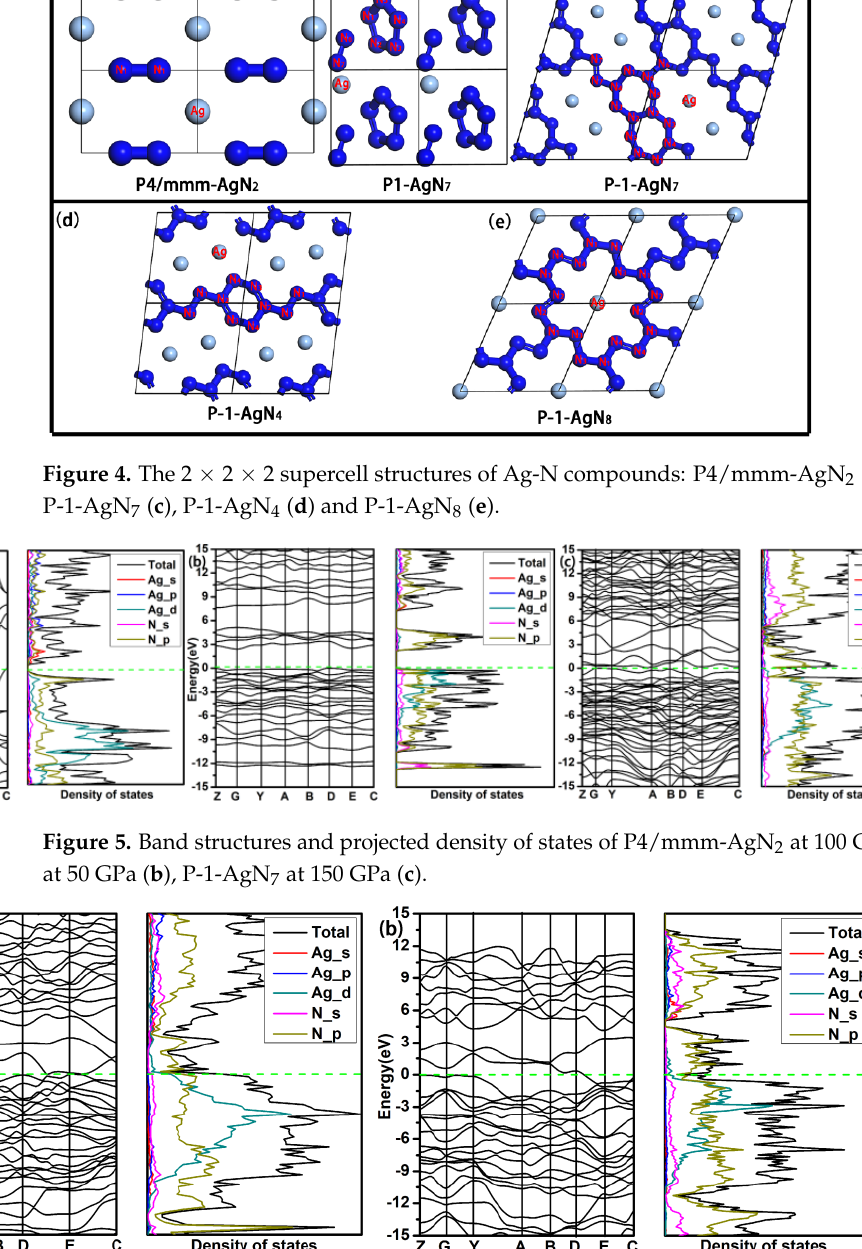
Figure 6. Band structures and projected density of states of P-1-AgN 4 ( a ) and P-1-AgN 8 ( b ) at 150 GPa.